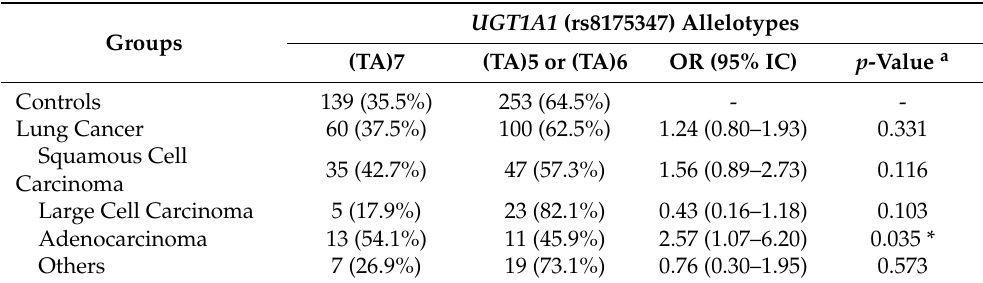
Table 2. Risk for lung cancer and its histological types, associated with the UGT1A1 gene polymor- phism allele.